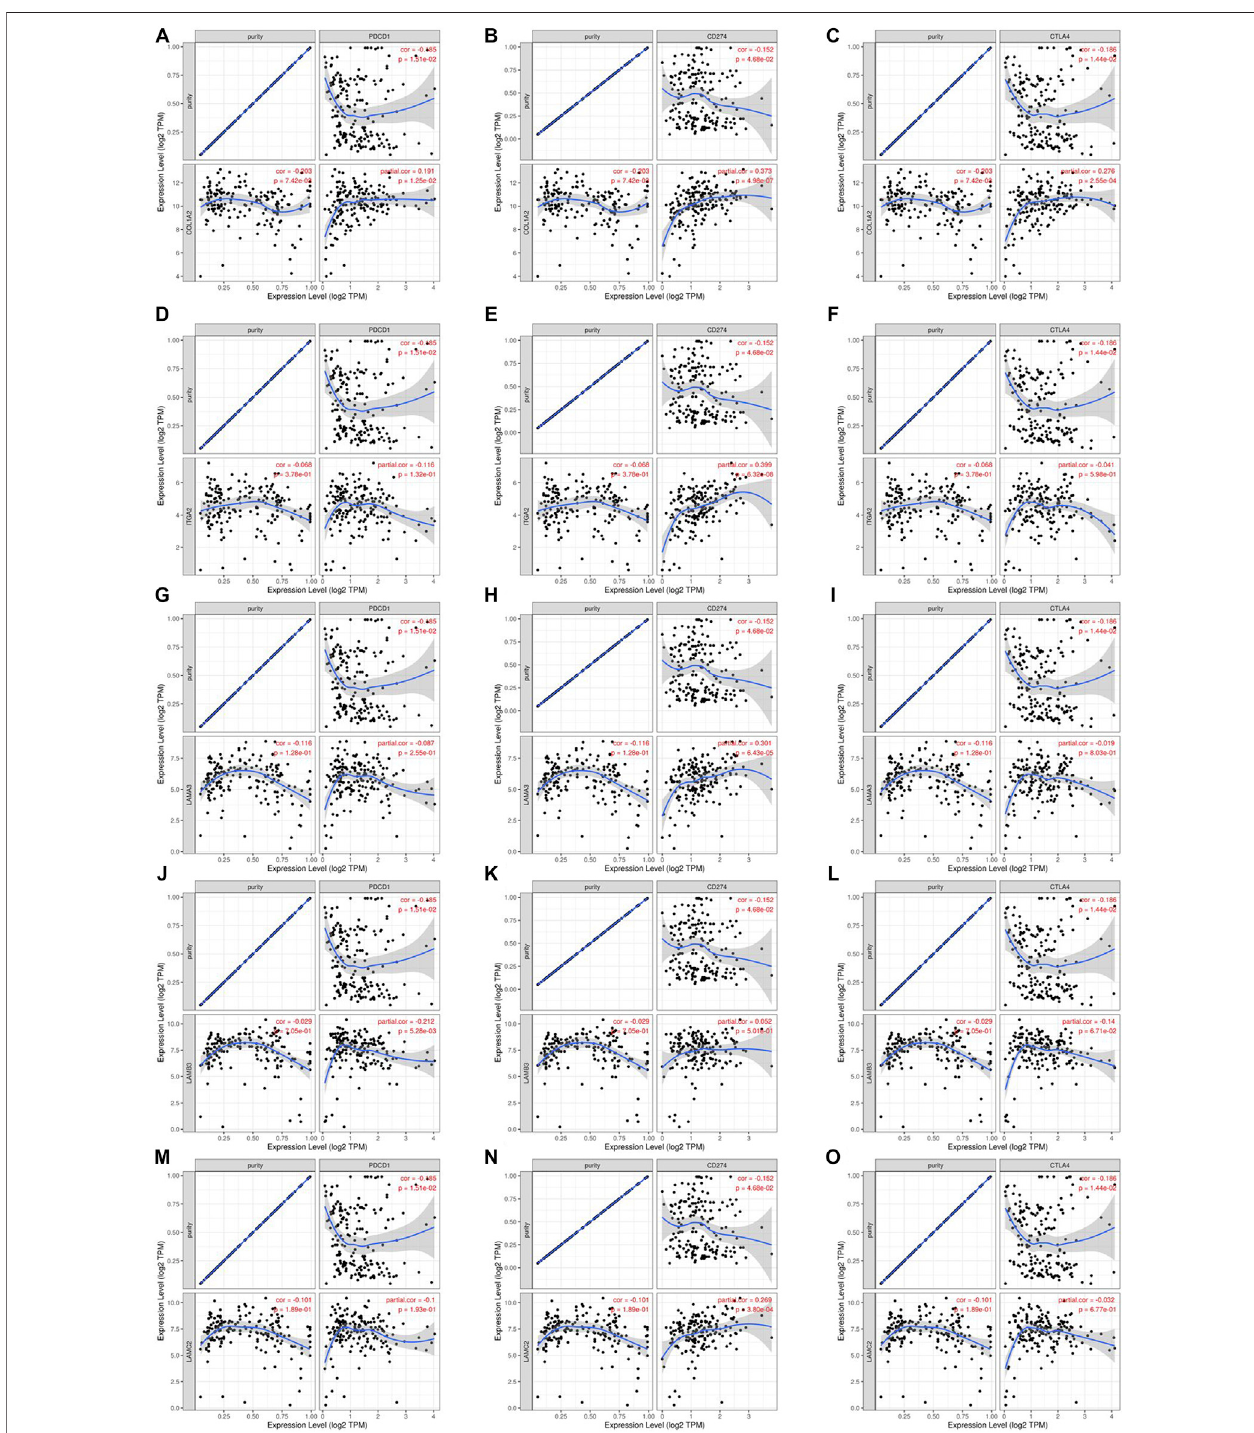
FIGURE 12 | Correlation of hub mRNA expression with PD-1, PD-L1, and CTLA-4 expression in PAAD. Spearman relationship of COL1A2 with an expression of PD-1 (A) ,PD-L1 (B) , and CTLA-4 (C) in PAAD adjusted by purity using TIMER. Spearmanrelationship ofITGA2 with anexpression ofPD-1 (D) , PD-L1 (E) ,and CTLA-4 (F) in PAAD adjusted by purity using TIMER. Spearman relationship of LAMA3 with an expression of PD-1 (G) , PD-L1 (H) , and CTLA-4 (I) in PAAD adjusted by purity using TIMER. Spearman relationship of LAMB3 with an expression of PD-1 (J) , PD-L1 (K) , and CTLA-4 (L) in PAAD adjusted by purity using TIMER. Spearman relationship of LAMC2 with an expression of PD-1 (M) , PD-L1 (N) , and CTLA-4 (O) in PAAD adjusted by purity using TIMER.